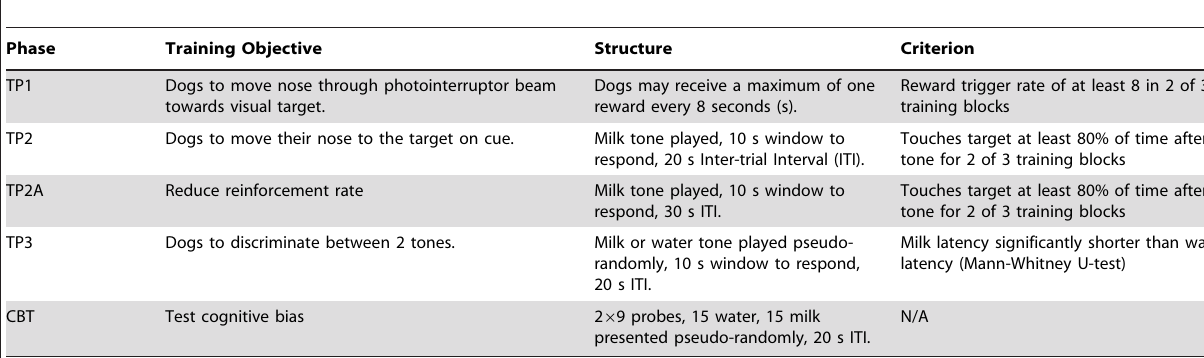
Table 3. Summary of training phases and cognitive bias testing